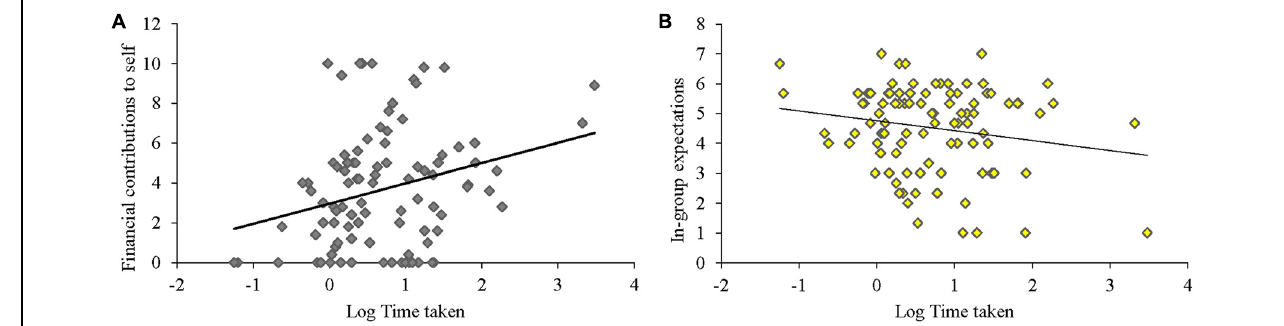
FIGURE 2 | Longer time used when deciding how much to keep to oneself (in seconds, log-transformed) associates with more selfish decision-making and less positive expectations of in-group members.